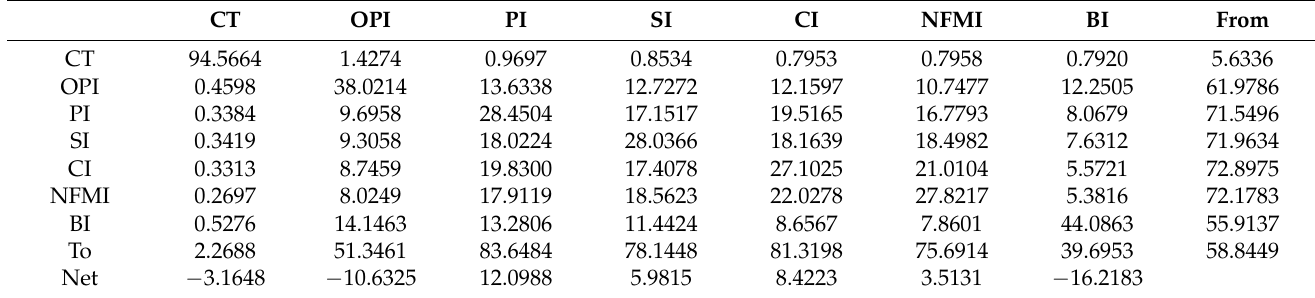
Table 3. Static risk spillover relationship between the carbon and stock markets across sectors.